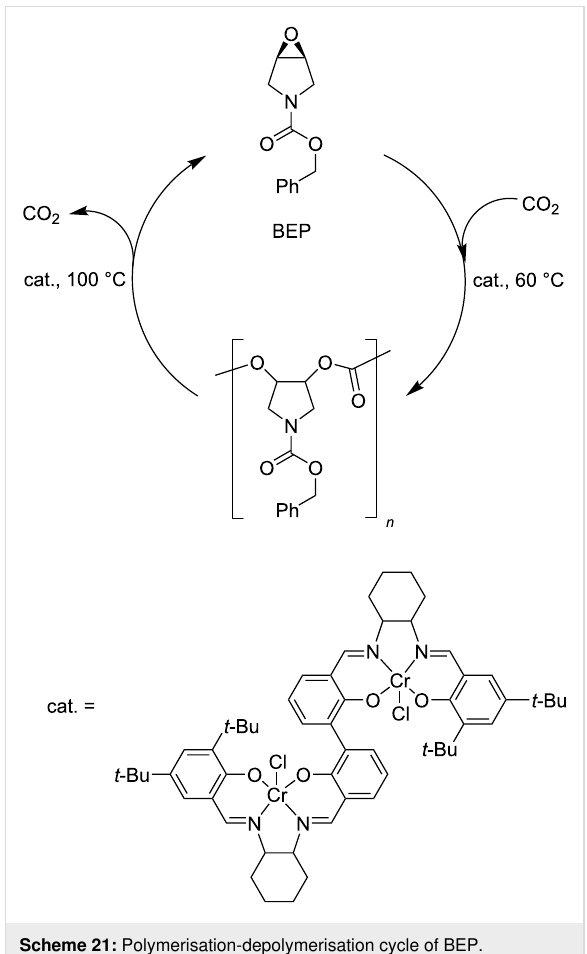
Scheme 21: Polymerisation-depolymerisation cycle of